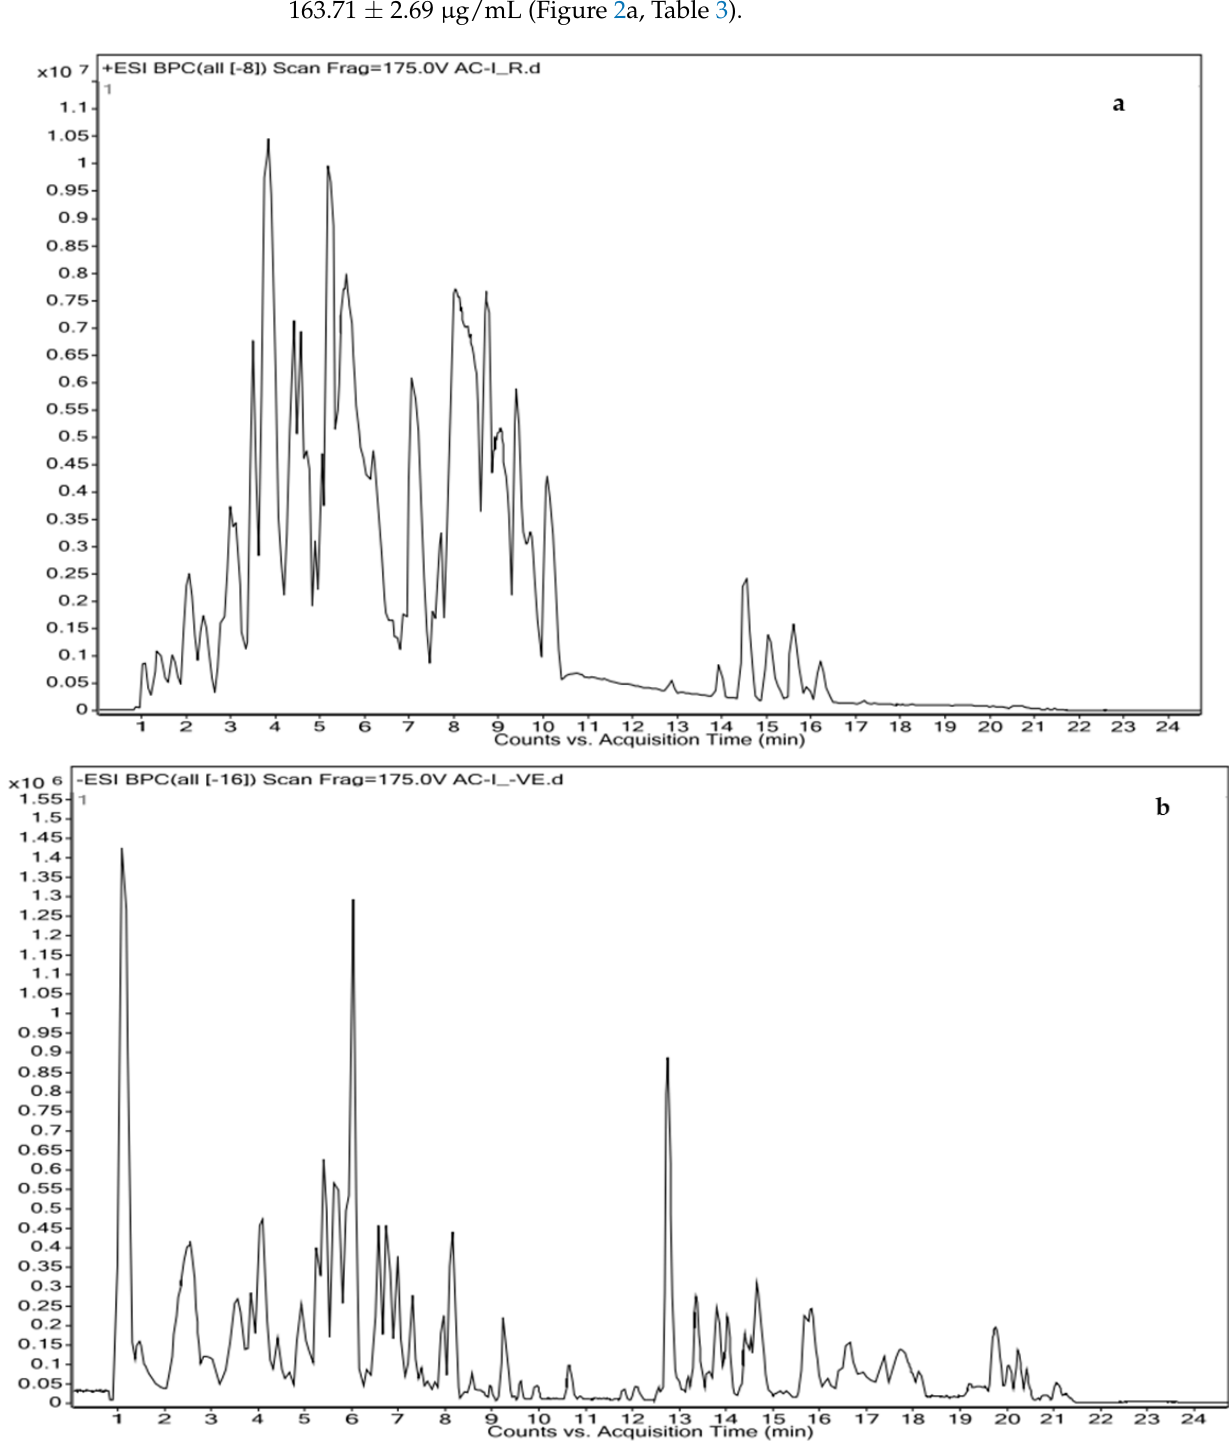
Figure 1. Main compounds identified in A. chasmanthum ethyl acetate extract of wild rhizome using the HR-LCMS technique. ( a ) ESI positive mode and ( b ) ESI negative